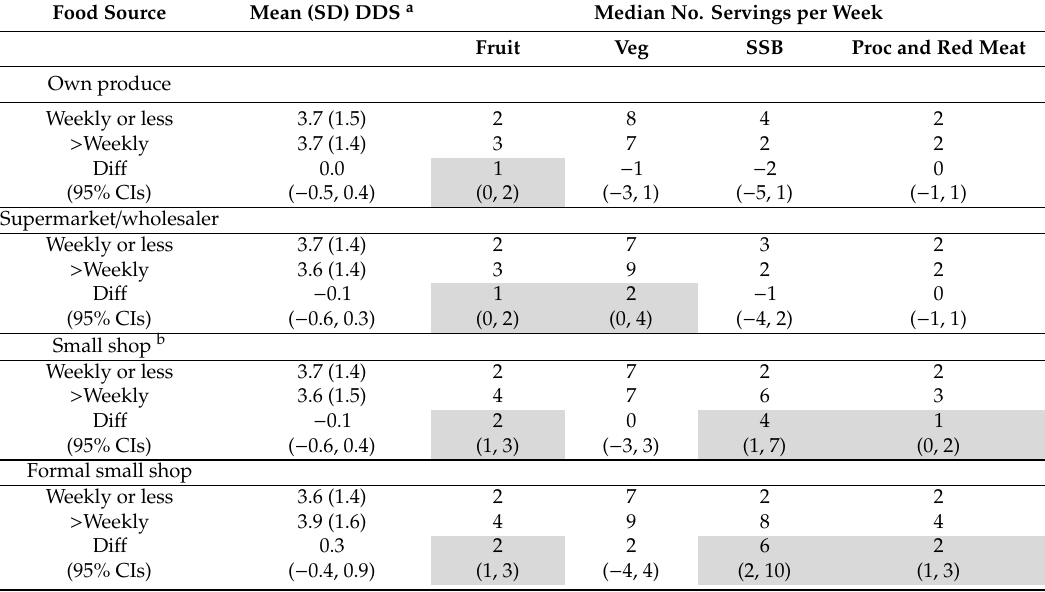
Table 6. Aspects of diet by frequency of use of selected food sources in the CFaH project in Fiji.